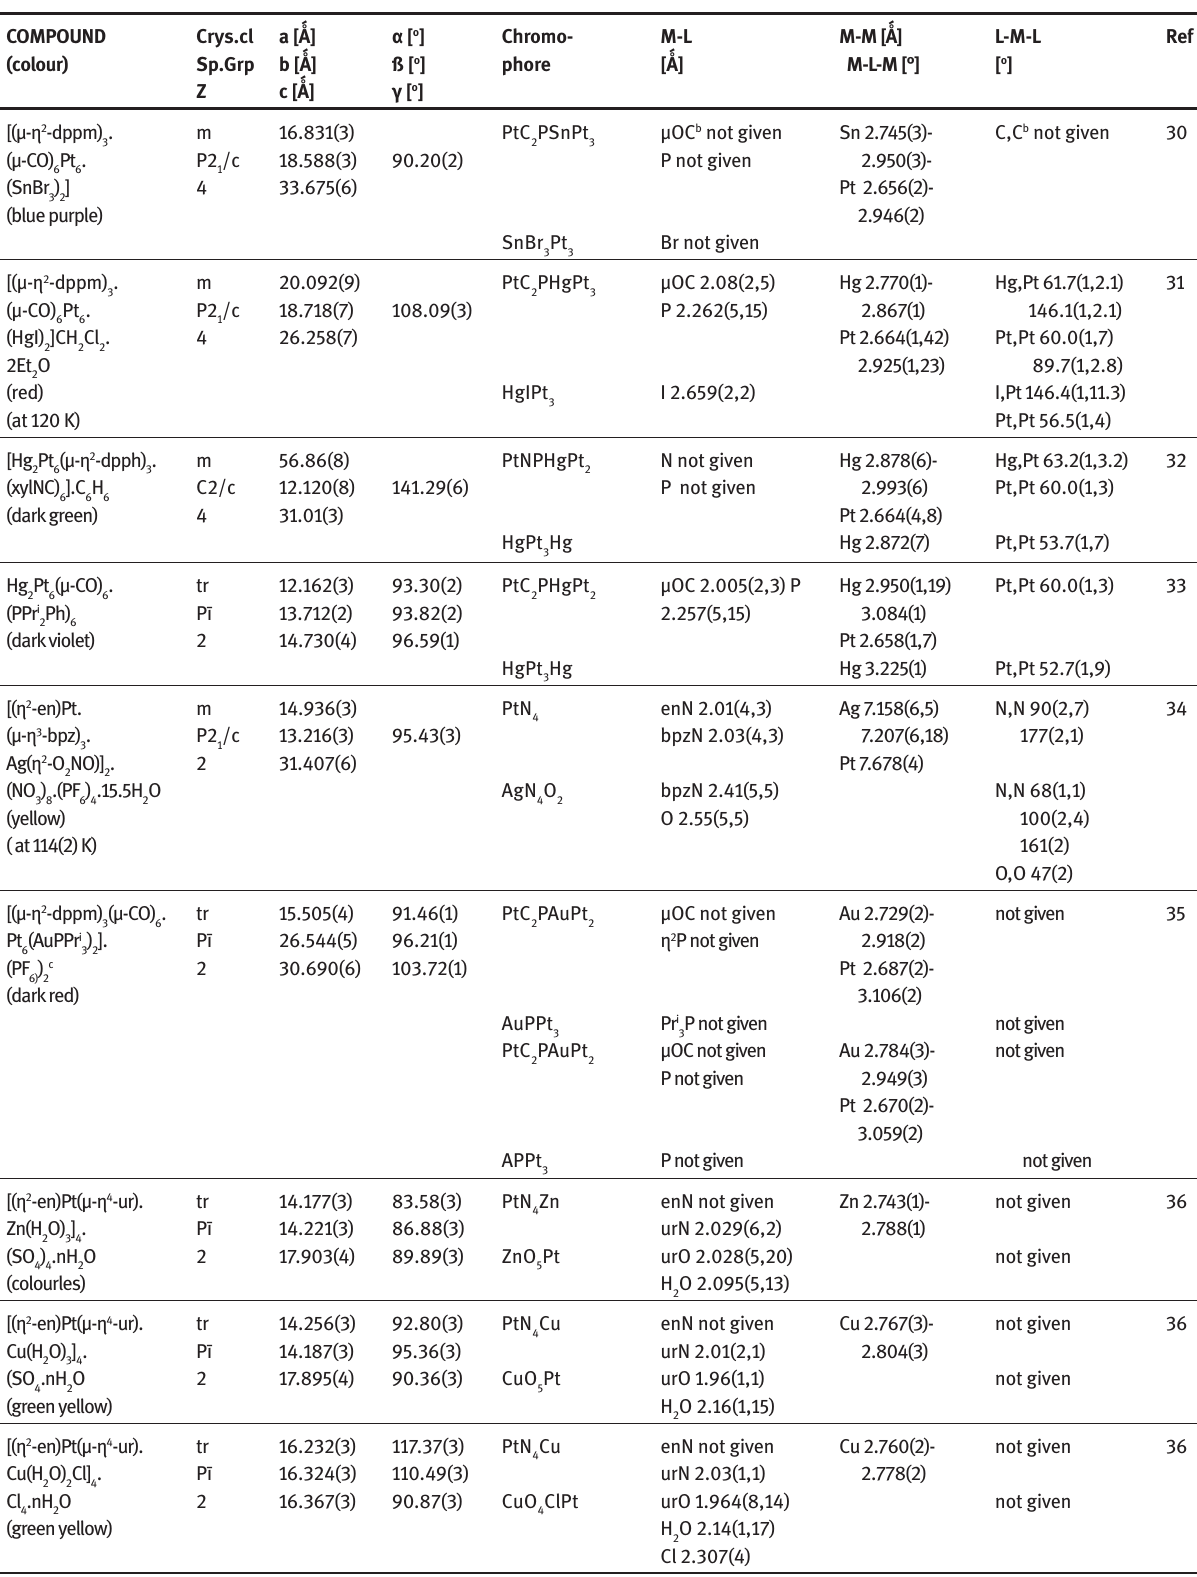
Table 3. Crystallographic and structural data for heterooctanuclear platinum clusters a